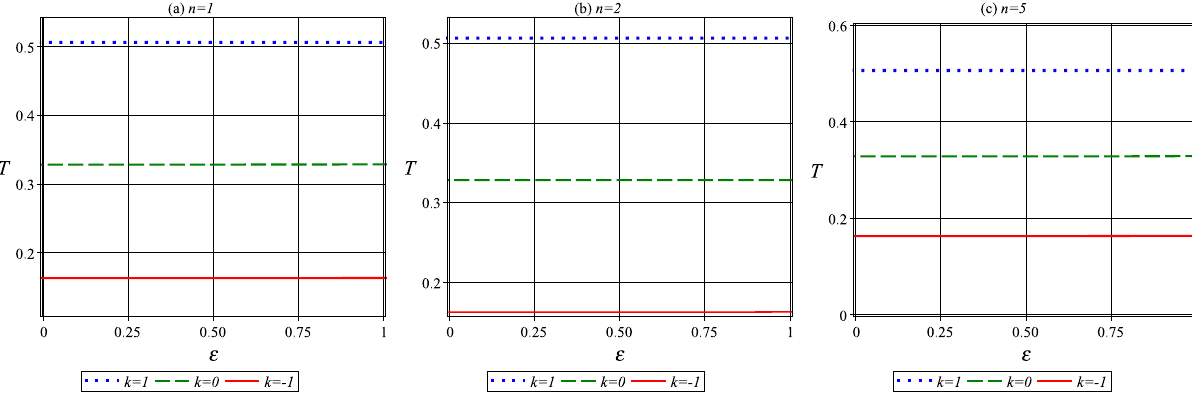
Fig. 3 Temperature of the first model (Eq. (3.7)) in terms of ε for η = 0 . 001 and r + = 0 . 6 (unit value for other parameters)